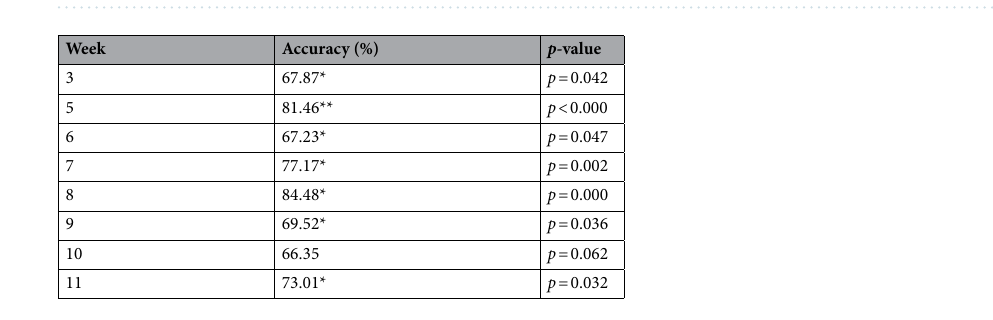
Table 2. Mean SVM classification accuracy at each timepoint after 1,000 bootstrapped runs, comparing between the superior colliculus electrode ipsilateral to the injection and superior colliculus electrode contralateral to the injection within α-synuclein rats. ** p < 0.001, * p <